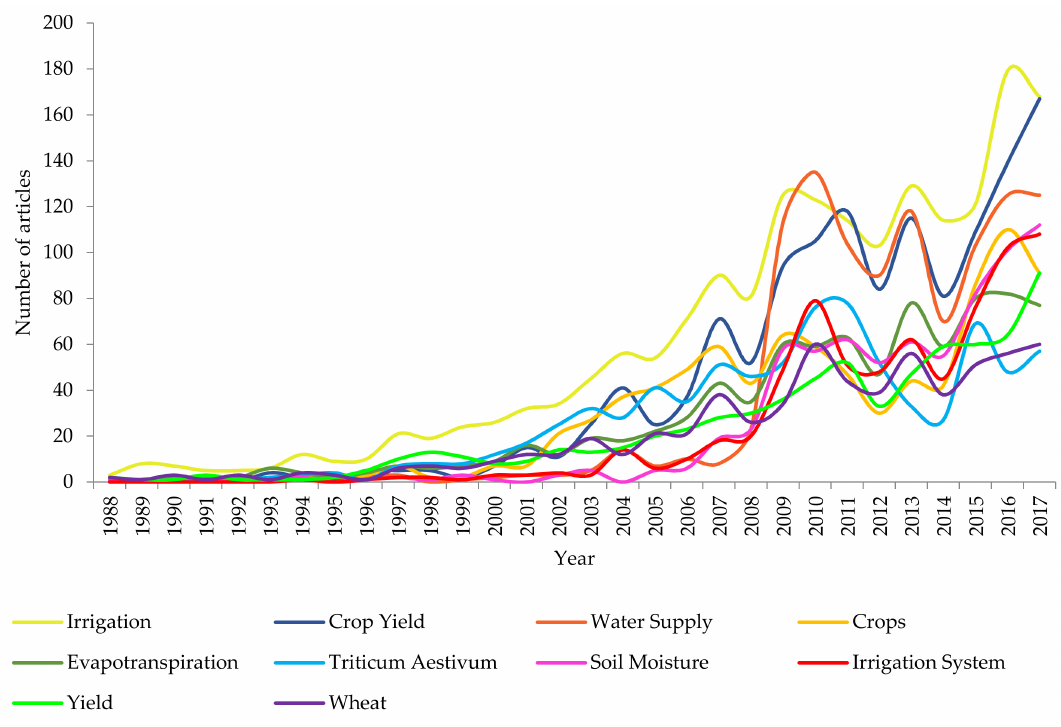
Figure 6. Trends of top ten keywords on WUEA research from 1988 to